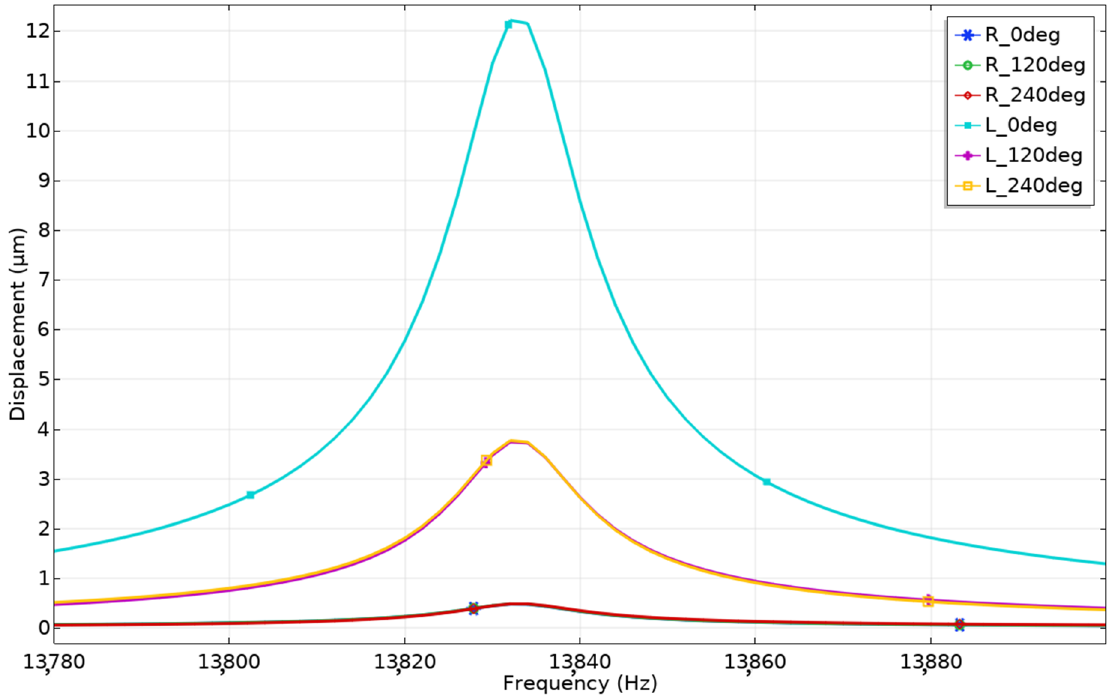
Figure 6. Amplitude-frequency characteristics of the robot when voltage 50 V p-p is applied to segment L 0deg .